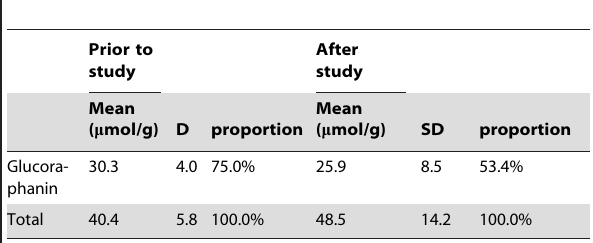
Table 7. Concentration of glucosinolates in the sprouts prior to and after the